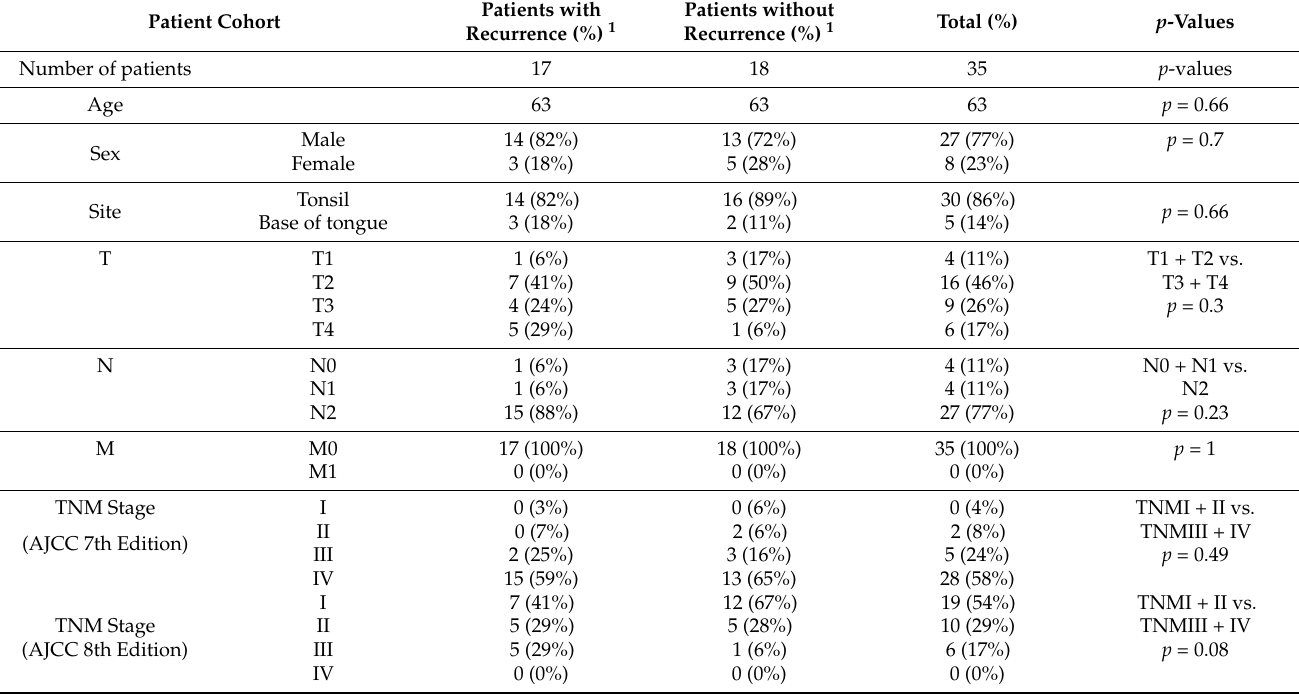
Table 1. Patient and primary tumour